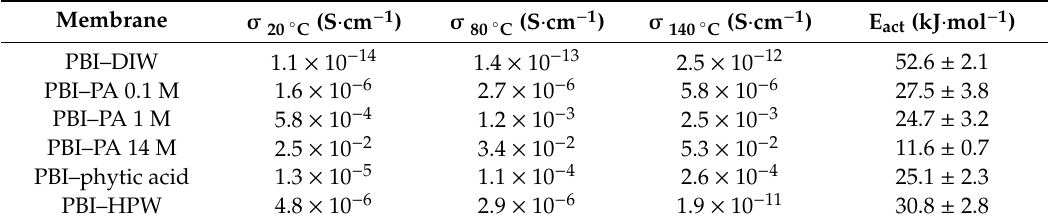
Table 3. Proton conductivities ( σ ) for all membranes under study at 20, 80, and 140 ◦ C (obtained from the first measurement ramp) and calculated activation energies (E act